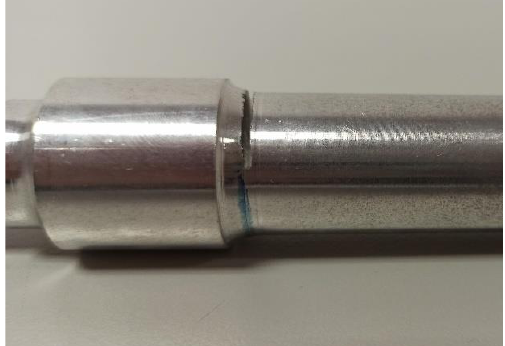
Figure 1. Cracked axle used to obtain vibratory signals.